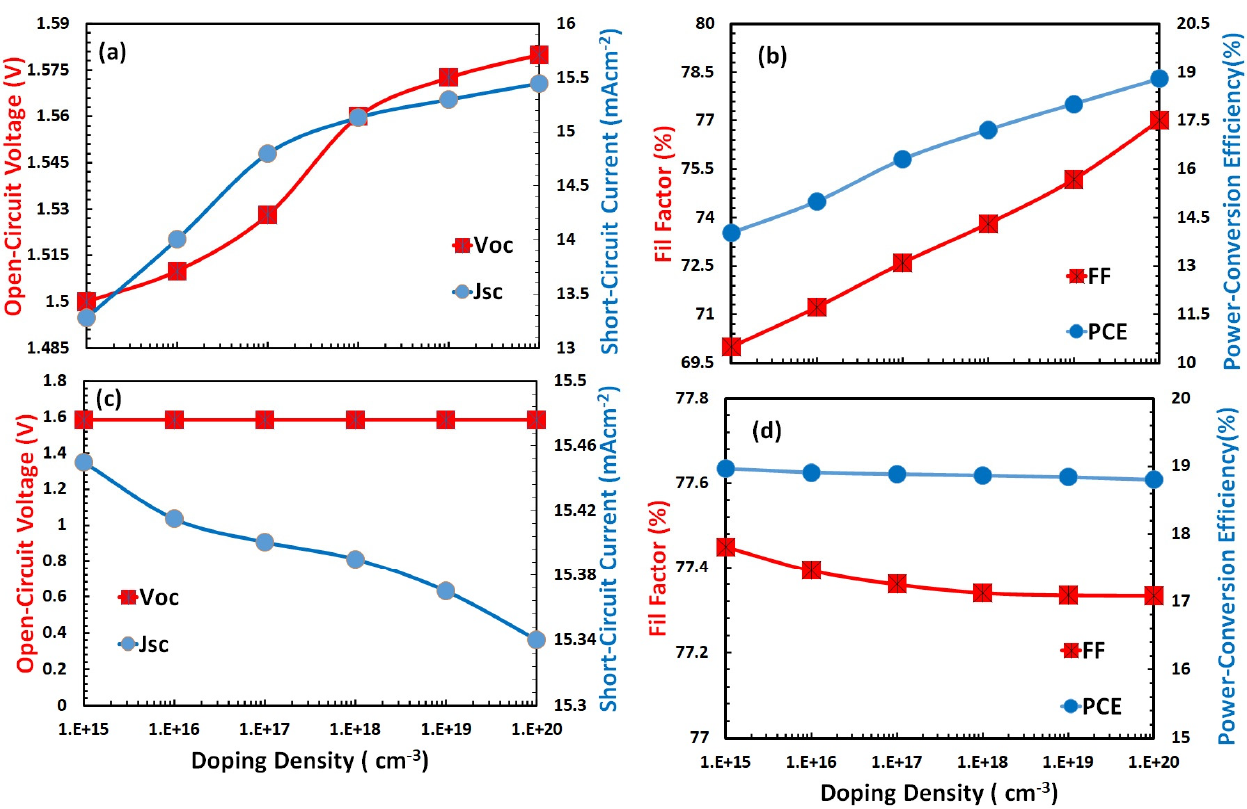
Figure 5. ( a ) Open-circuit voltage, short-circuit current, ( b ) fill factor, and power conversion efficiency of HTL as a function of electron affinity. ( c ) Open-circuit voltage, short-circuit current, ( d ) fill factor, and power conversion efficiency of ETL as a function of doping density for Cs2TiBr6-based solar cell.